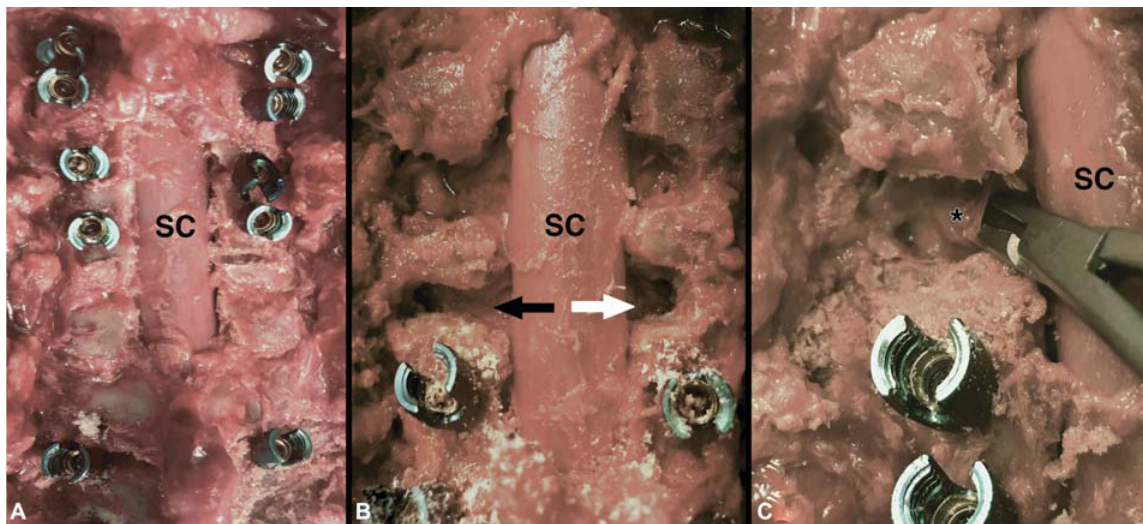
Fig. 3 ( A ) Exposure of the cervical spinal cord after C1 – T2 instrumentation and laminectomy demonstrating the clinical feasibility of nerve root untethering.( B )Enlargedviewofbothastandardforaminotomy(whitearrow,right-side)and “ extendedforaminotomy ” (blackarrow,left-side).( C )Enlarged viewofthe “ extendedforaminotomy ” from( B )atthebeginningofthenerverootuntetheringviaforaminalligament(markedby (cid:2)